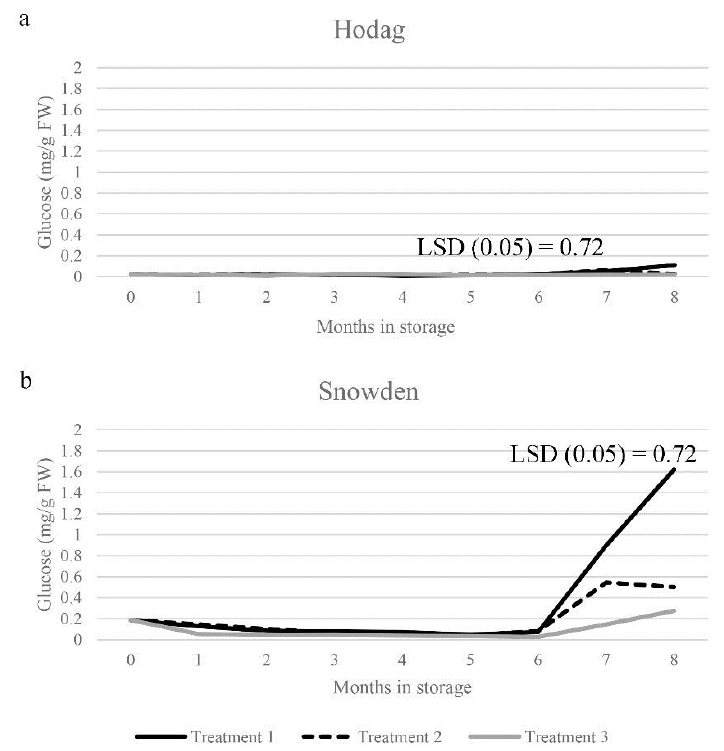
Figure 6. Glucose content (mg / g Fresh Weight) of Hodag ( a ), Snowden ( b ) under the three wound healing treatments in